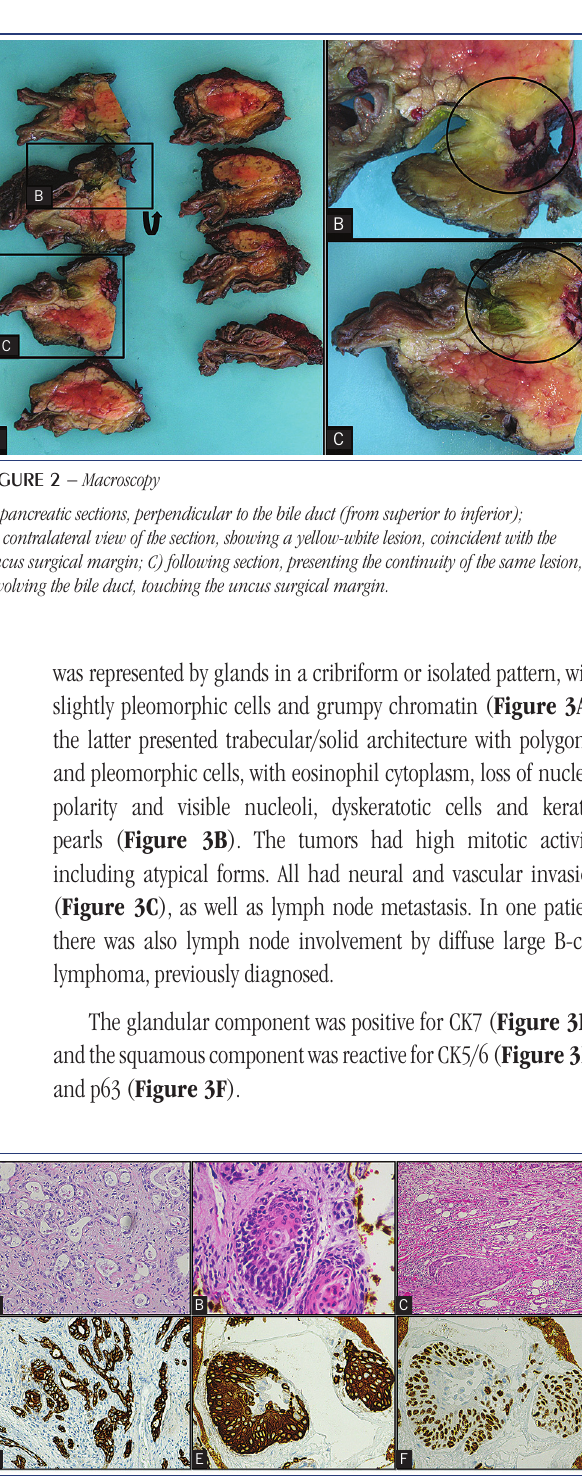
figurE 3 − Microscopy A) HE 200×, glandular component; B) HE 400×, squamous component; C) HE 100×, neural invasion; D) CK7 immunostaining 200×, highlighting the glandular component; E) CK5/6 400×, immunolabeling in the squamous component; F) P63 400×, nuclei staining in the squamous component cells. HE: hematoxylin and eosin.